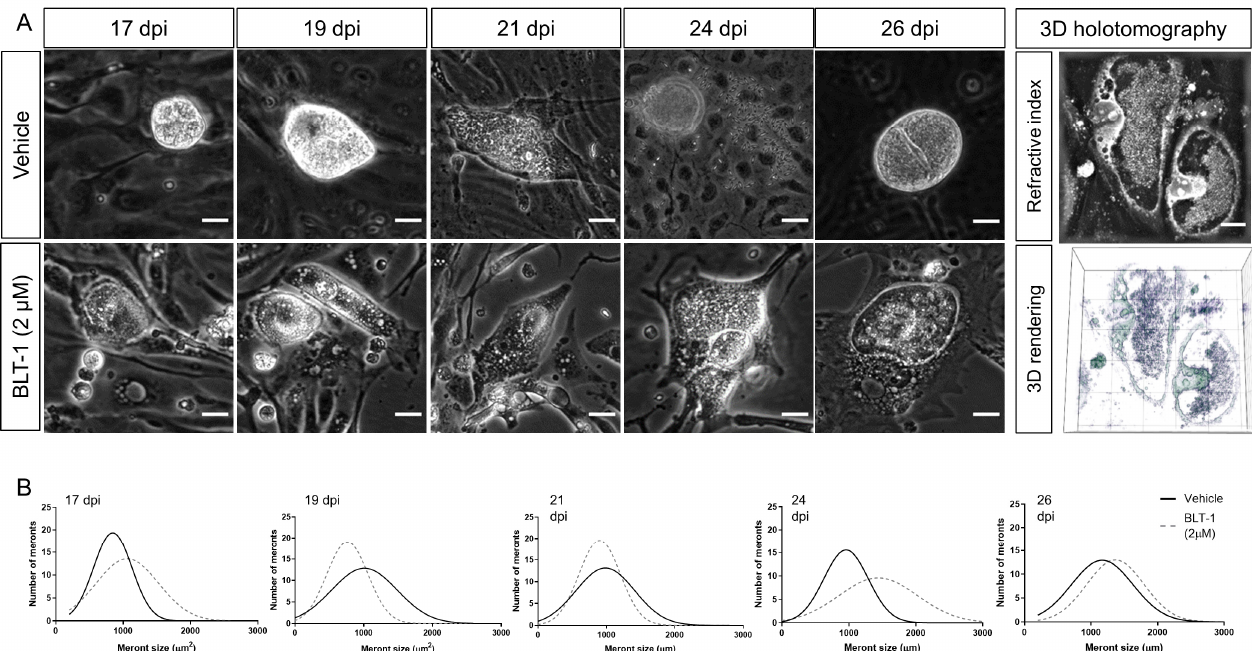
Figure 3. Effects of BLT-1 treatments on E. arloingi macromeront development in primary bovine umbilical vein endothelial cells (BUVEC). ( A ) Representative phase-contrast imaging of E. arloingi macromeronts at days 17, 19, 21, 24, 26 p.i. in the vehicle- or BLT-1-treated BUVEC and exemplary live cell 3D holotomography analysis of the BLT-1-treated E. arloingi - infected BUVEC at 22 d p.i. Note: vacuolization of host cells and macromeronts. ( B ) Macromeront numbers over time in the vehicle- and BLT-1-treated E. arloingi -infected BUVEC as a frequency distribution histogram. Scale bar: 5 μ m.